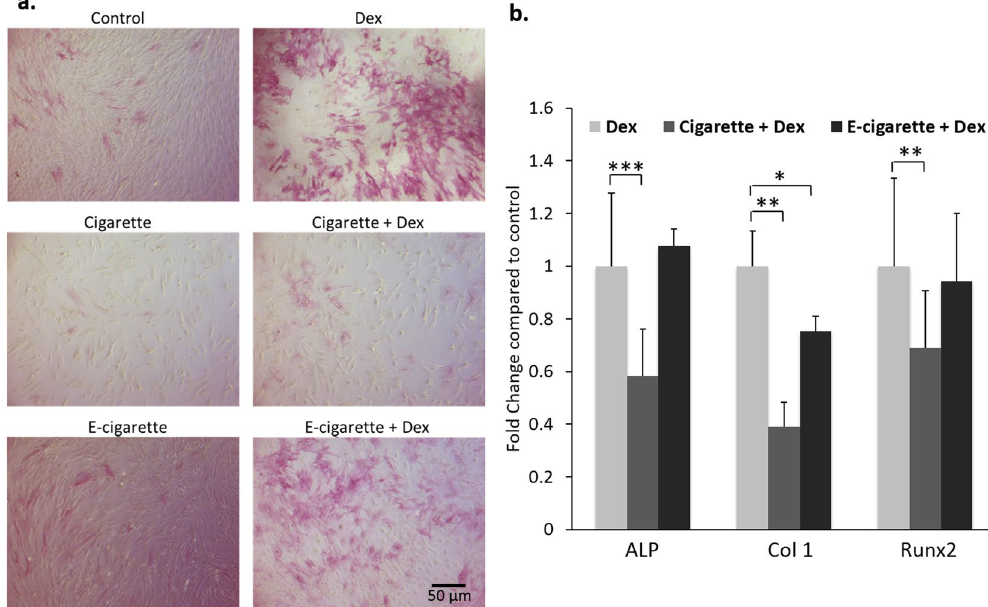
Figure 2. Cigarette and e-cigarette smoke extracts attenuate MSC differentiation. ( a ) MSCs were induced into osteogenic differentiation by treatment with 50 nM Dex for 14 days. ALP activity was then assessed using a chromogenic ALP assay where purple staining indicates ALP activity. The light microscopy images are representative of 3 independent experiments. ( b ) MSCs were simultaneously treated with 50 nM Dex for osteogenic differentiation and cigarette or e-cigarette smoke extracts for 14 days. Expression of osteogenic markers (alkaline phosphatase [ALP], collagen 1 [Col 1] and Runt-related transcription factor 2 [Runx2]) was then assessed using qRT-PCR. Histograms display data normalized against GAPDH and show fold changes relative to control. Results are displayed as averages ± SD of 3 independent experiments. * p < 0.05, ** p < 0.01 and *** p <